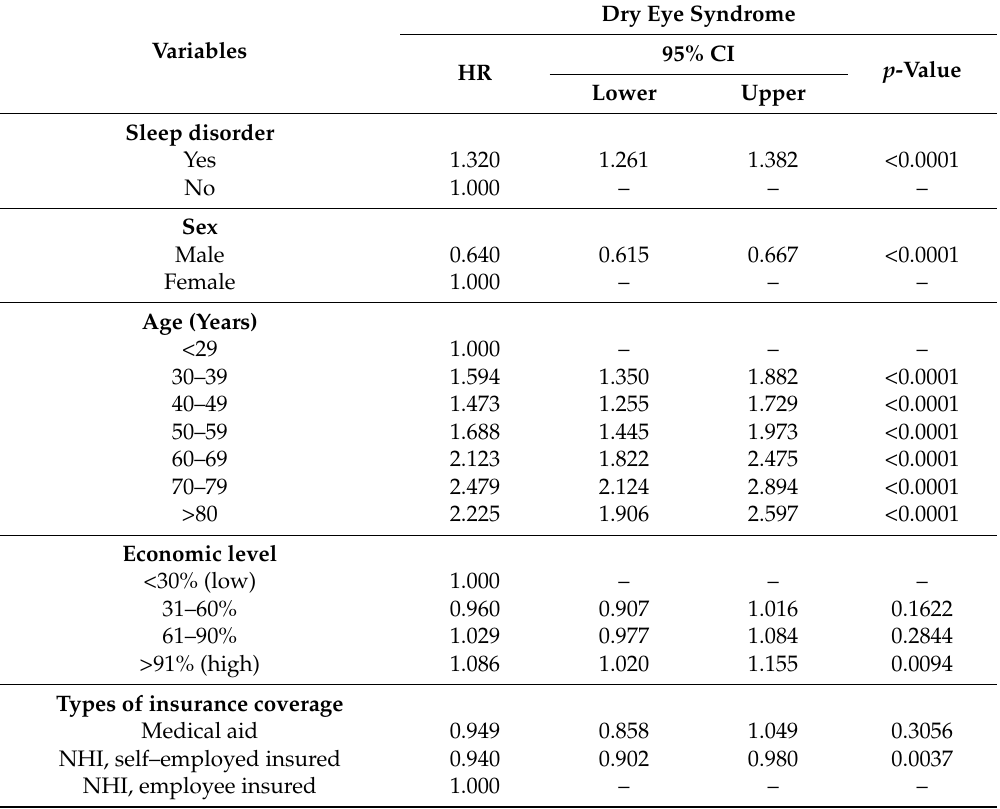
Table 2. Results of survival analysis using Cox proportional hazard model for association between sleep disorders and dry eye syndrome.